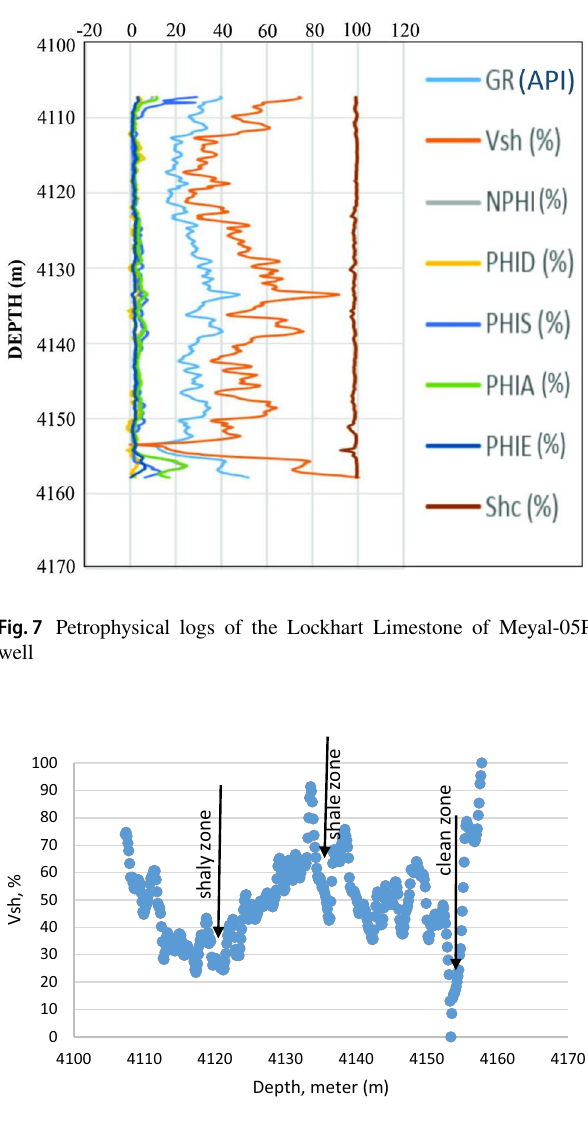
Fig. 8 Shale, shaly and clean zones within the Lockhart Limestone of Meyal-05P, Meyal Oil Field